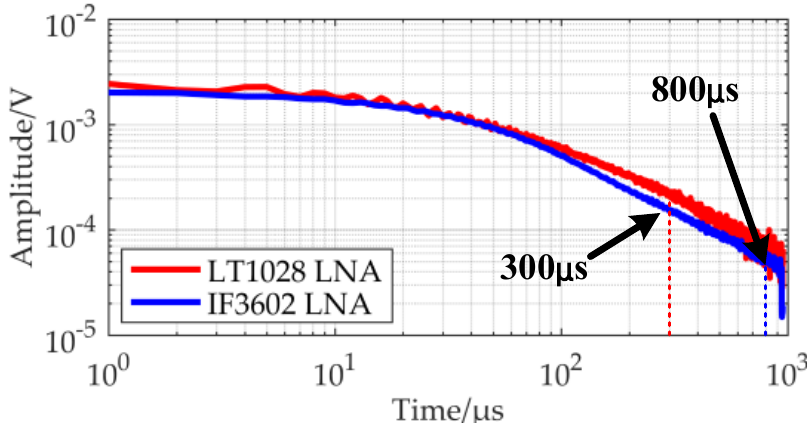
Figure 15. Comparison of the data observed by the receiving device in the laboratory.